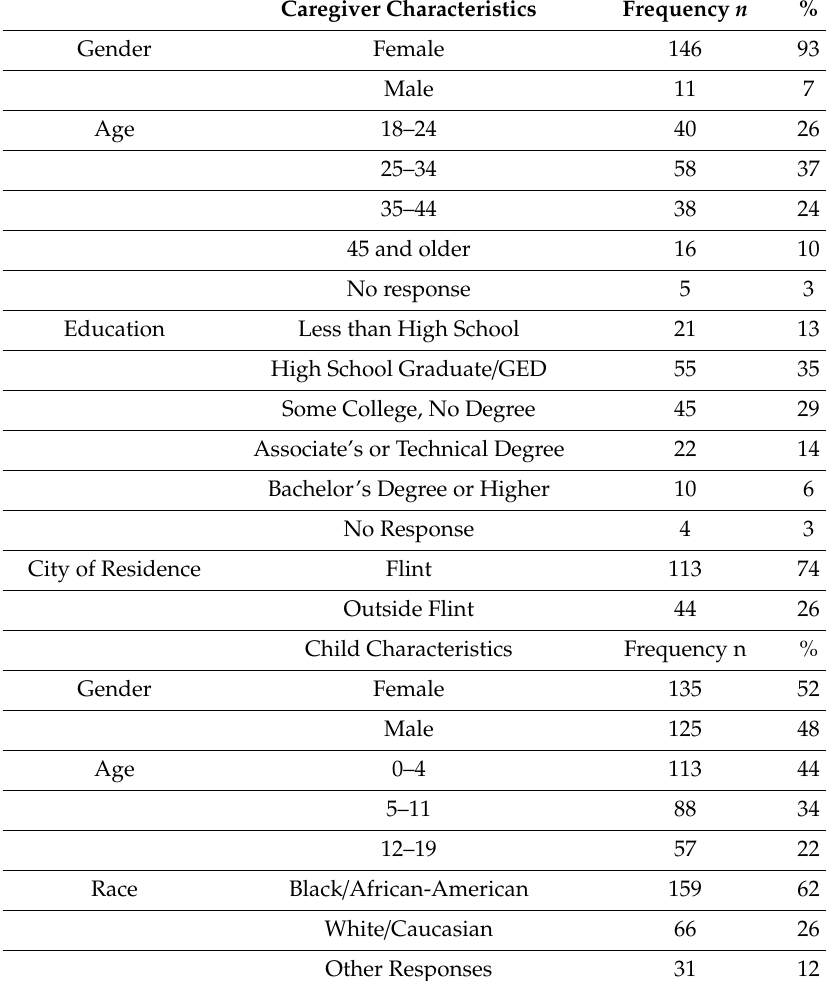
Table 1. Characteristics of caregivers who completed a survey exploring participation in a fruit and vegetable prescription program for pediatric patients and farmers’ market shopping.